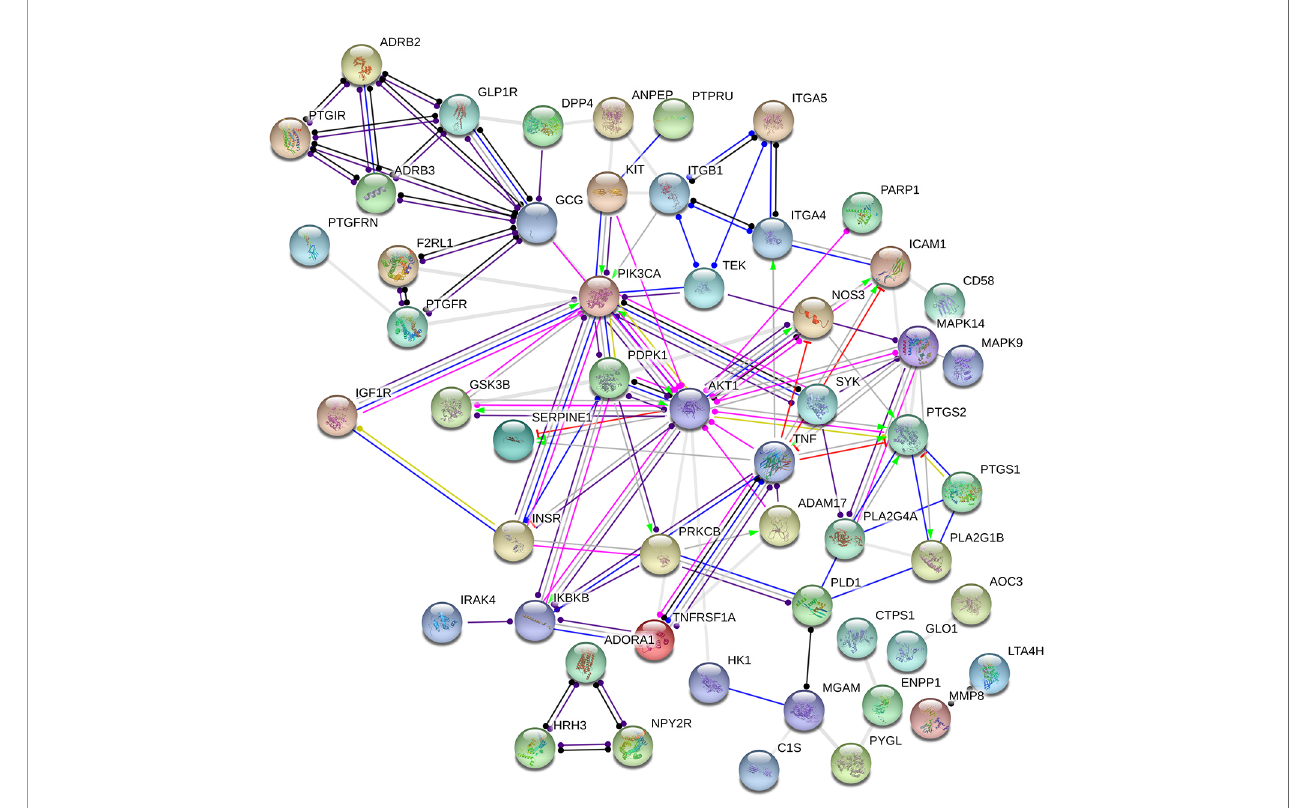
FIGURE 3 | Protein – protein interaction (PPI) network analysis.